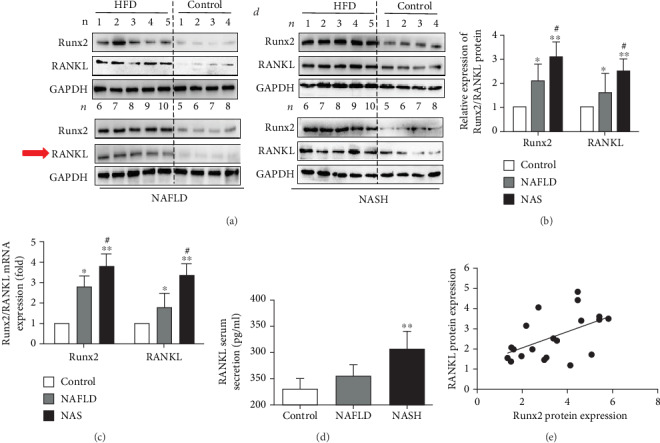
Both RANKL and Runx2 increased during NAFLD development. (a) RANKL and Runx2 protein expressions in the liver were identified by western blot. (b) Statistical analysis of the protein expression of RANKL and Runx2. (c) Relative mRNA expressions of RANKL and Runx2 were detected by Real-Time PCR. (d) Serum productions of RANKL were measured by ELISA. (e) The correlation between Runx2 and RANKL protein expression in the HFD group. 8 ≤ n ≤ 10. ∗P < 0.05 vs. controls, ∗∗P < 0.01 vs. controls, and #P > 0.05 vs. NAFLD.